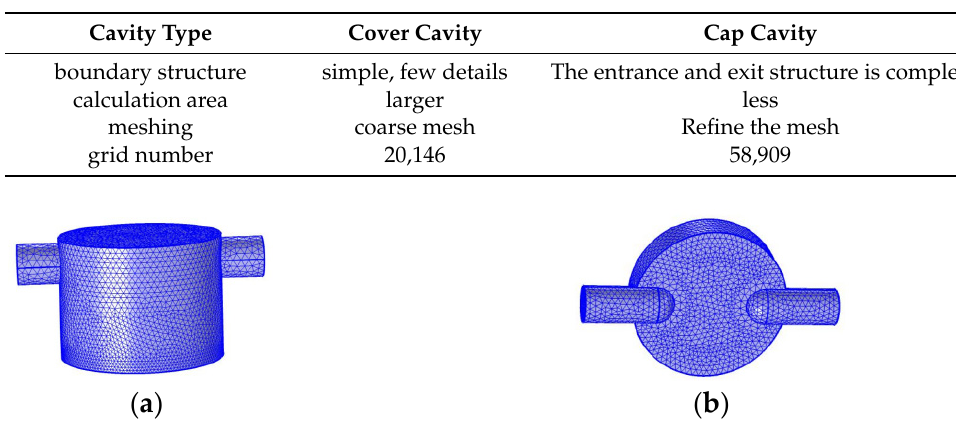
Table 4. Cavity type